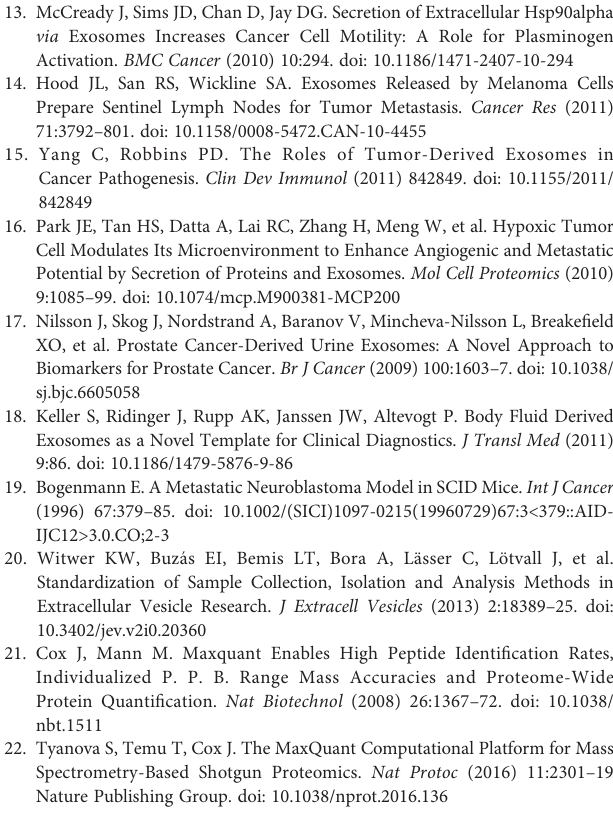
Analysis (NTA) of plasma derived EVs. B, Cd63 marker detection by western blotting. C, Flow Cytometry Analysis. Supplementary Figure S2 | Proteomic analysis using iTRAQ. A and B, iRegulon basedpredictionoftranscriptionfactorsidenti fi edYY1andSTAT1asregulatorsofa number of proteins that are up-regulated in the early stages of glioma. Supplementary Table 1 | Survival status of the collected glioma patients. Supplementary Table 2 | CD63 expression in different grades of glioma (I, II, III and controls). Supplementary Data | Excel sheet of LC-MS/MS